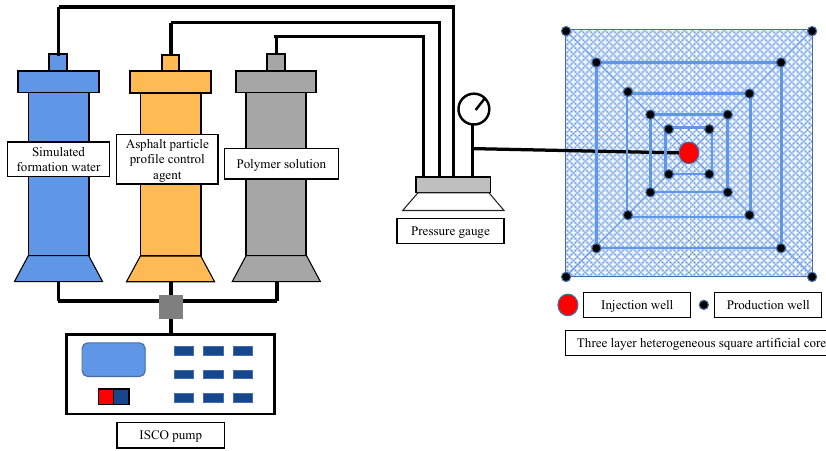
Figure 3. Experiment device for optimization of profile control radius.